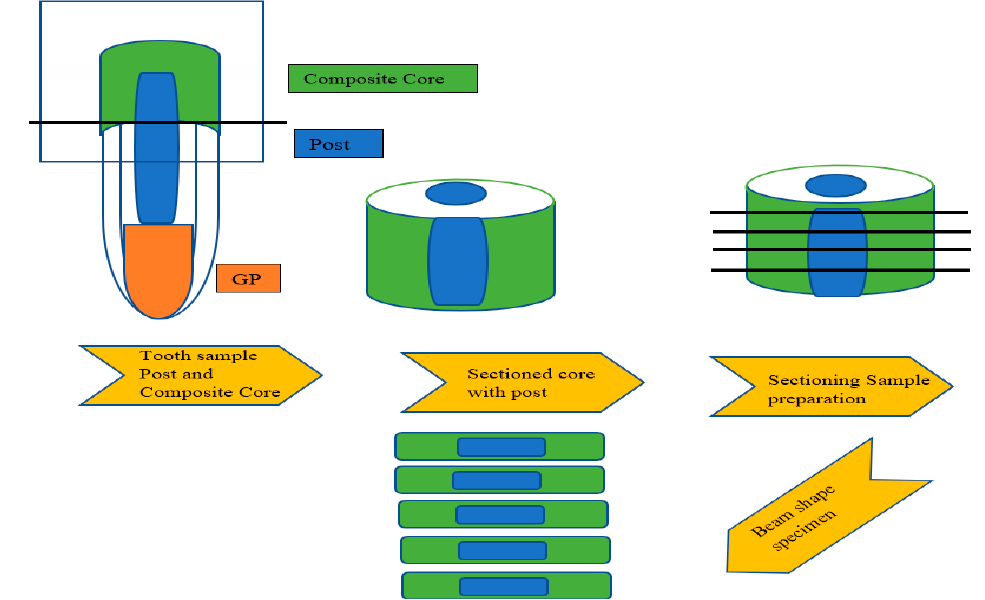
Figure 1. Schematic representation of samples prepared for micro-tensile bond strength.